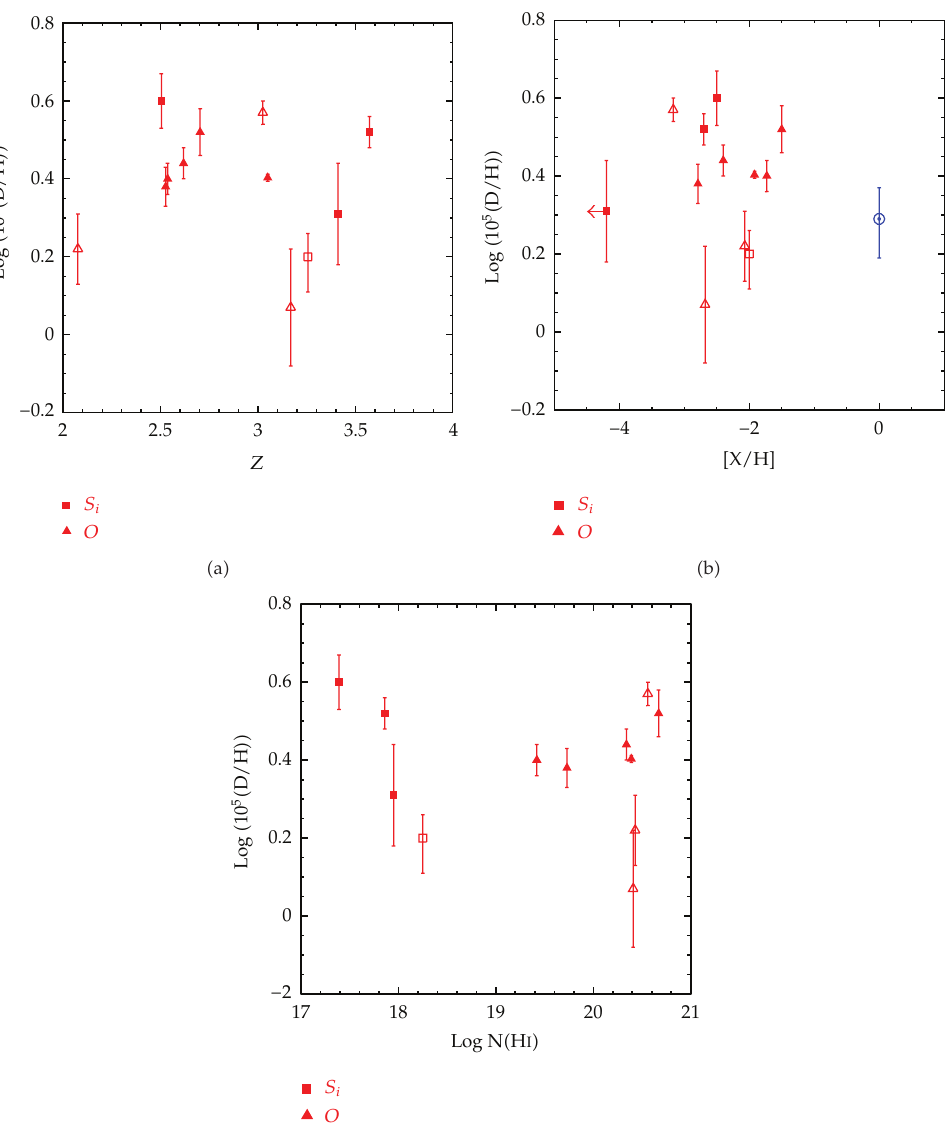
Figure 1: The log of the deuterium abundances (cid:3) y D ≡ 10 5 (cid:3) D/H (cid:4)(cid:4) , and their 1 σ uncertainties, inferred from 12 low- Z , high- z QSOALS. In (cid:3) a (cid:4) y D is shown as a function of the redshift. In (cid:3) b (cid:4) y D is shown as a function of the metallicity (cid:3) squares for silicon and triangles for oxygen (cid:4) . In (cid:3) c (cid:4) y D is shown as a function of the neutral hydrogen column density. The filled symbols reflect a subjective determination of the more robust determinations of D/H compared to the open symbols. The blue solar symbol in (cid:3) b (cid:4) is the solar system (cid:3) presolar nebula (cid:4) D abundance (cid:5) 23 (cid:6)